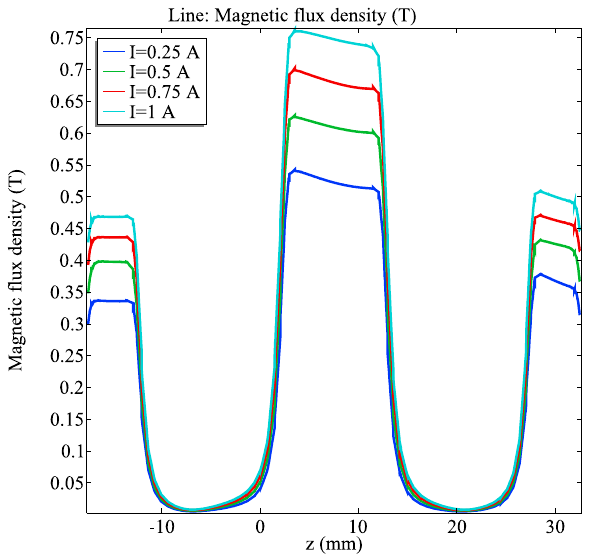
Figure 5. Magnetic induction intensity in the middle line of damping gap at different currents.